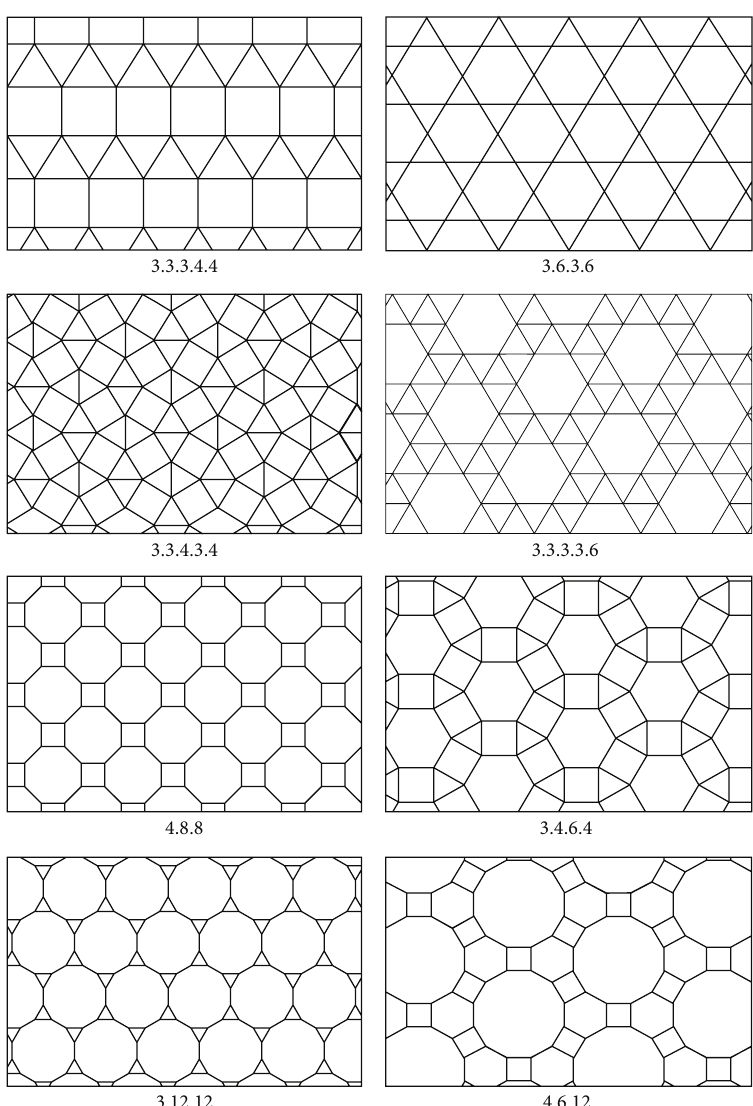
Figure 2: Equilateral polygon combinations.